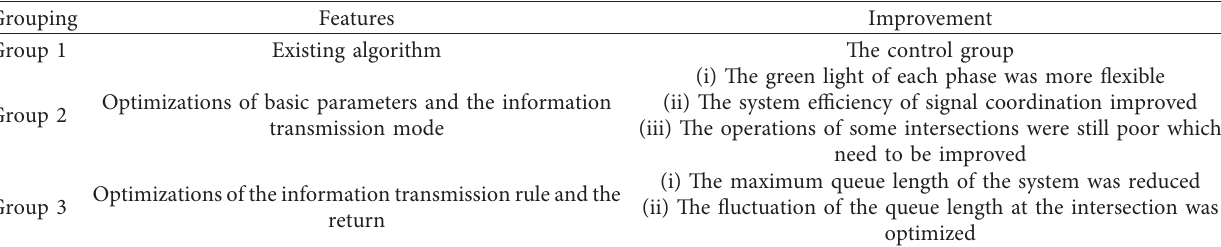
Figure 12: Fluctuations in queue length at intersection 5 under differentiated returns and a low congestion level. Table 5: Summary of improvement effect on the JTA-based RL